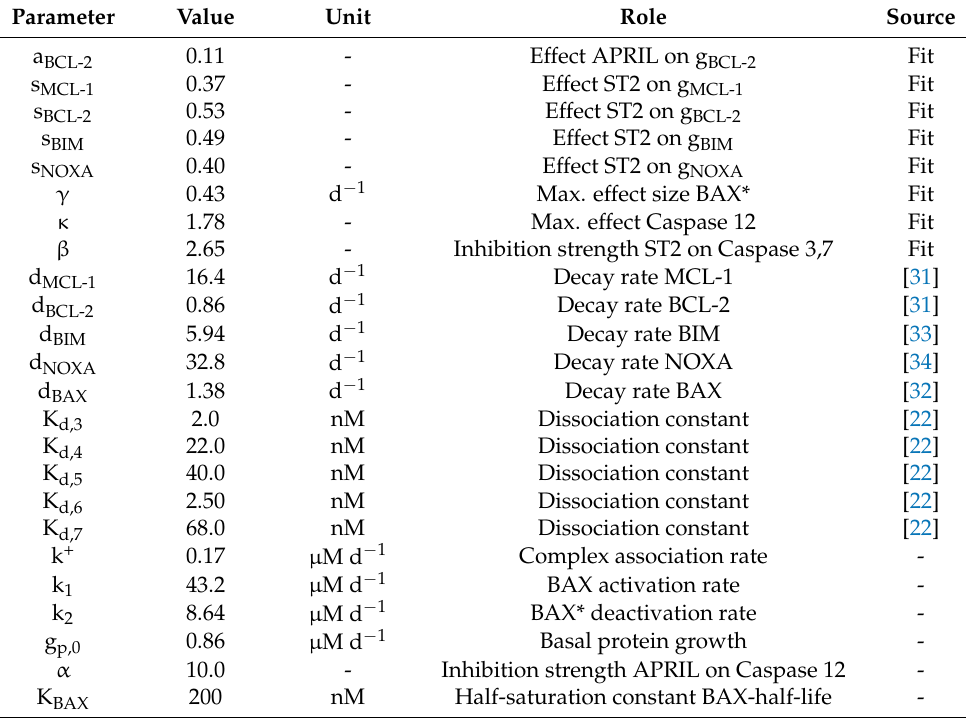
Table 2. Parameter values used in the mathematical models.